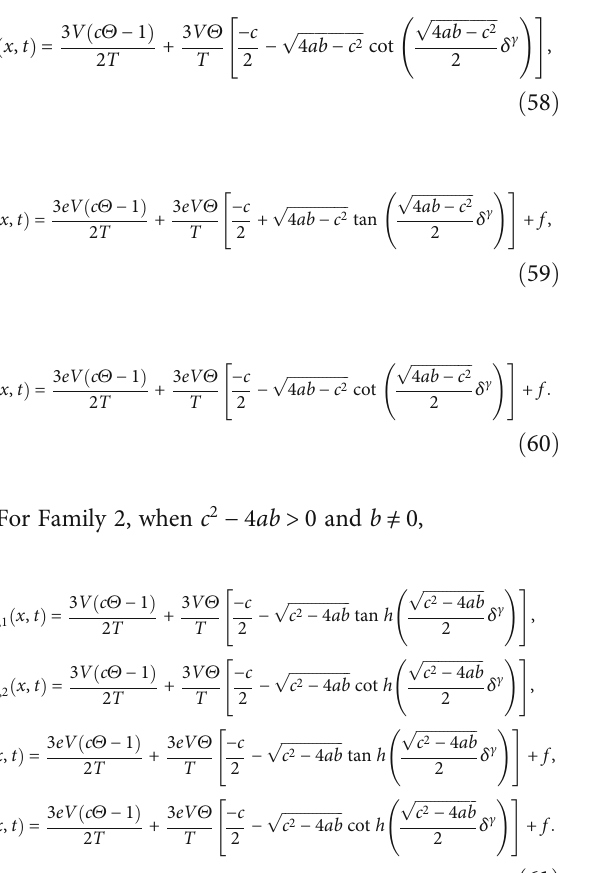
Figure 6: We take κ = − 1 , β γ = 0 : 3 . (b) The 2D graph of u